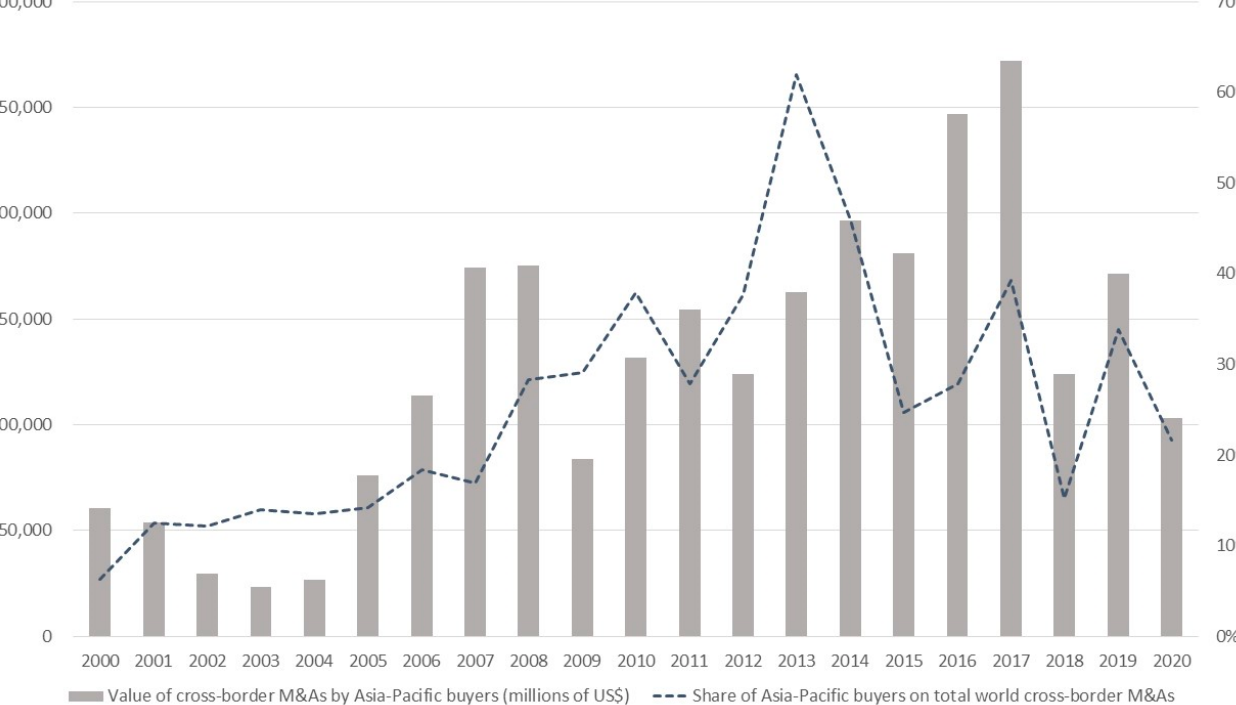
Figure A2. Value and share of cross-border M&As by purchasers from the Asia-Pacific region, 2000–2020. Source: calculated by authors from the UNCTAD data provided at https://worldinvestmentreport.unctad.org/annex-tables/ (accessed on 25 September 2021). Note: the Asia-Pacific region is defined as Asia, Australia, New Zealand and Oceania (based on the UNCTAD